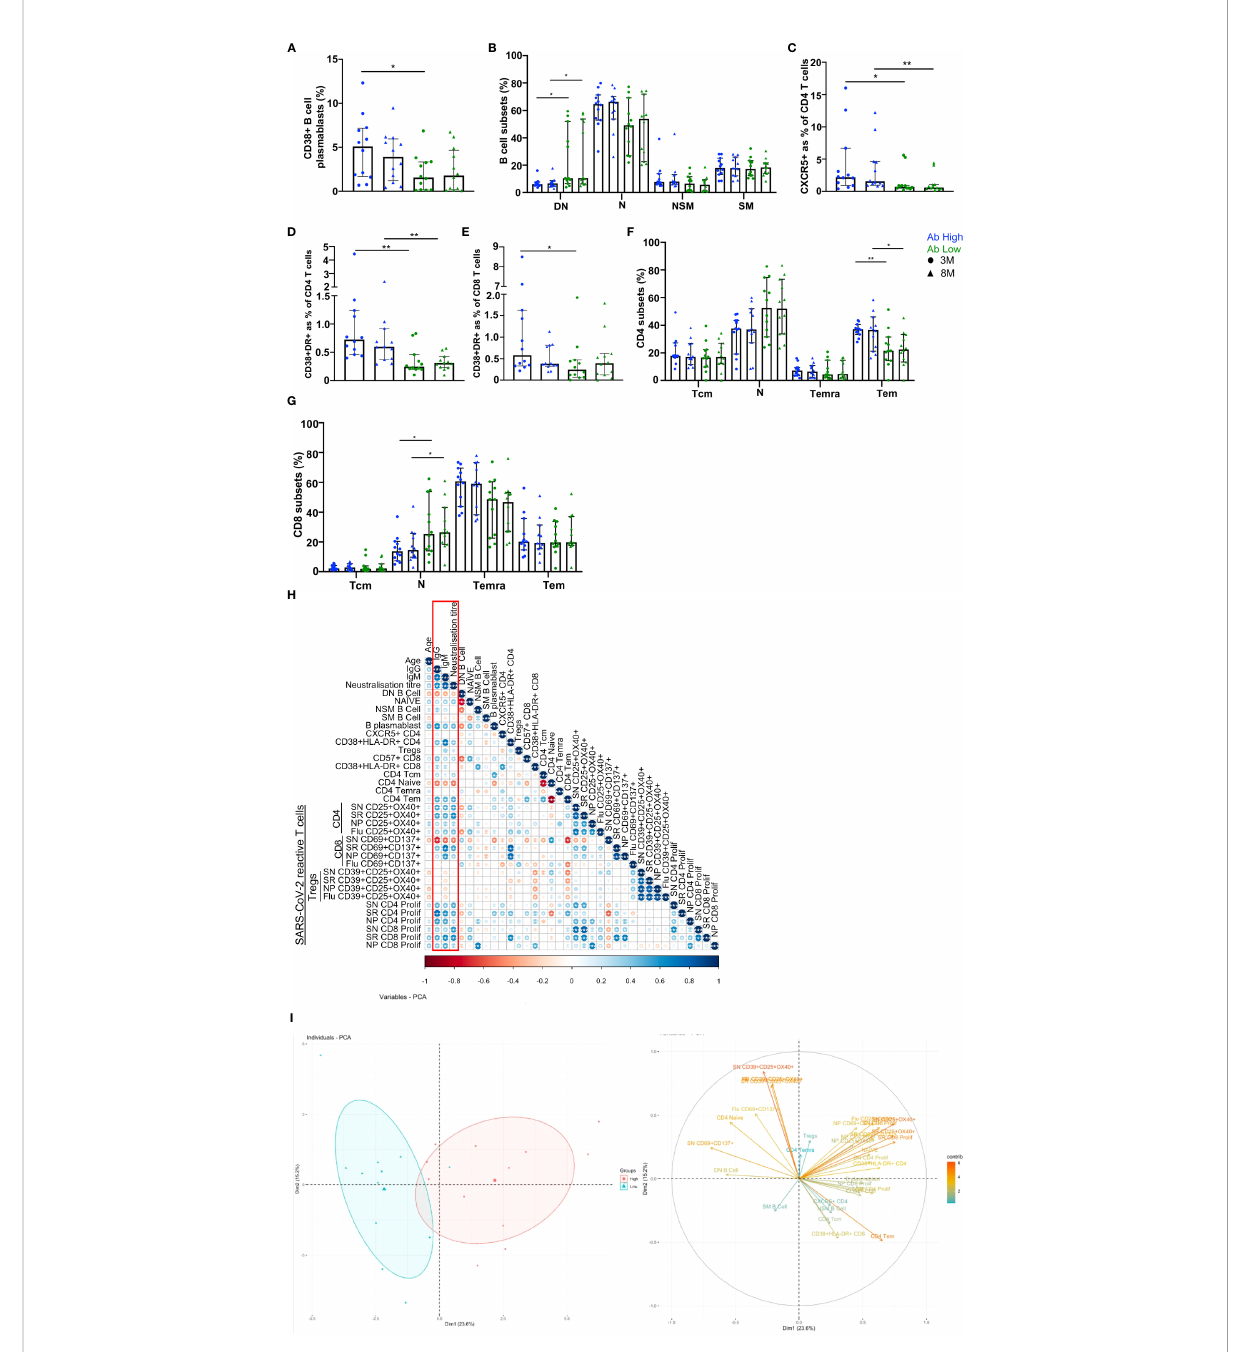
FIGURE 5 B and T cell parameters correlate with antibody response. (A) Higher CD38+ B cell plasmablasts in Ab high group. (B) Elevated double negative (DN, IgD-CD127-) B cells in Ab low group. Naïve (N, IgD+CD127-), non-switched memory (NSM, IgD+CD127+), switched memory (SM, IgD- CD127+) B cells. Higher CXCR5 expression on CD4s (C) , activation (CD38+HLA-DR+) on CD4 (D) and CD8 (E) and CD4 effector memory cells (F) in Ab High compared to Ab low group. Data shown as medians with interquartile ranges. (G) Higher naiïve CD8+ T cells in Ab low group at both timepoints. SN (spike), SR (RBD), NP (nucleoprotein). Two-tailed p values <0.05 were considered signi fi cant (*<0.05, **<0.01, ***<0.001). Mann-Whitney T tests were used for unpaired groups. (H) B cell plasmablast, CXCR5+ CD4 T cells, activated CD4 and CD8 T cells, proliferative Spike and RBD-speci fi c CD4 positively correlate with humoral response at 3 months post-infection (red box). (I) PCA clustering of Ab high and Ab low groups based on T and B cell parameters. Pearson ’ s rho was used for correlations and adjusted p values shown with Benjamini- Hochberg correction used for multiple comparisons. Two-tailed p values <0.05 were considered signi fi cant (*<0.05, **<0.01,